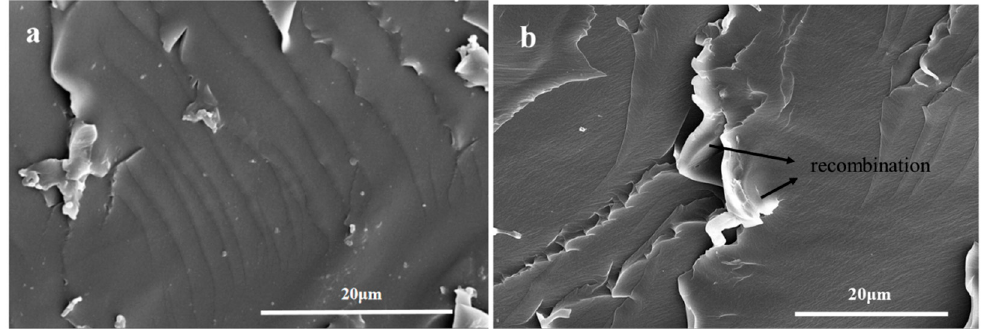
Figure 7. ( a ) AFM images of the surface, and SEM images of the fracture surface, ( b ) before and ( c , d ) after healing for the TO/TMMP-TMTGE self-healing composite. Figure 8. SEM images of the fracture surface ( a ) before and ( b ) after healing for the TMMP-TMTGE self-healing material.